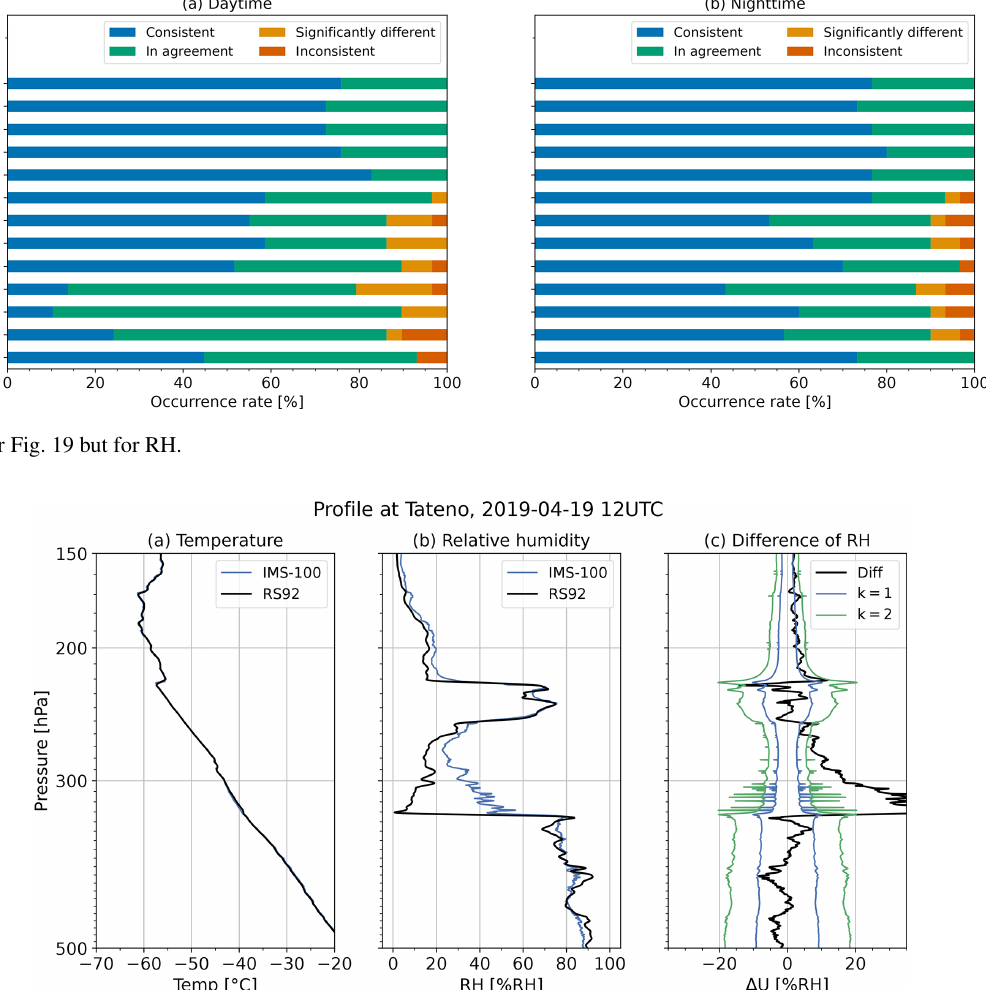
Figure 24. Comparison between 500 and 150hPa levels (L3 to L5) at 12:00UTC (21:00LT) on 19 April 2019. (a) Temperature. (b) RH. (c) RH